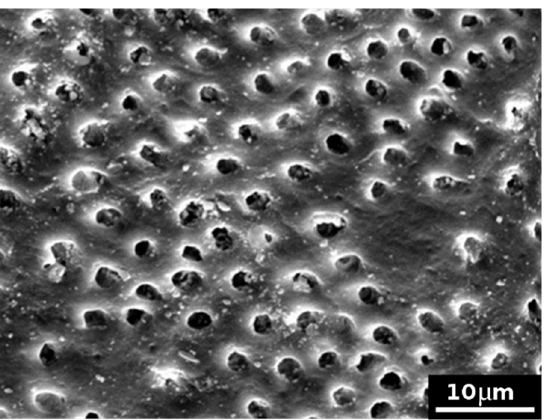
Figure 9. SEM picture (×2000) of model dentin treated with formulation 2 and successively ex- posed to citric acid attack, showing several widely opened tubules.